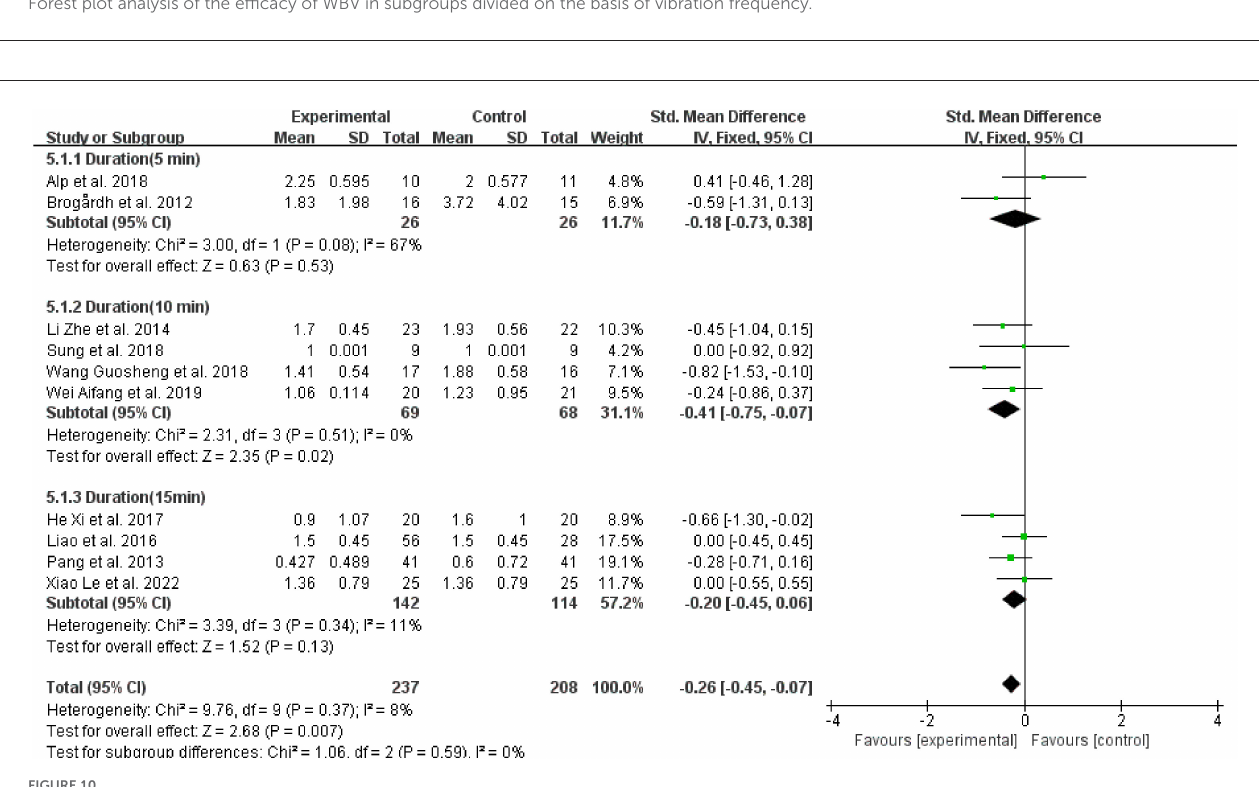
FIGURE10 Forest plot analysis of the efficacy of WBV in subgroups divided on the basis of vibration